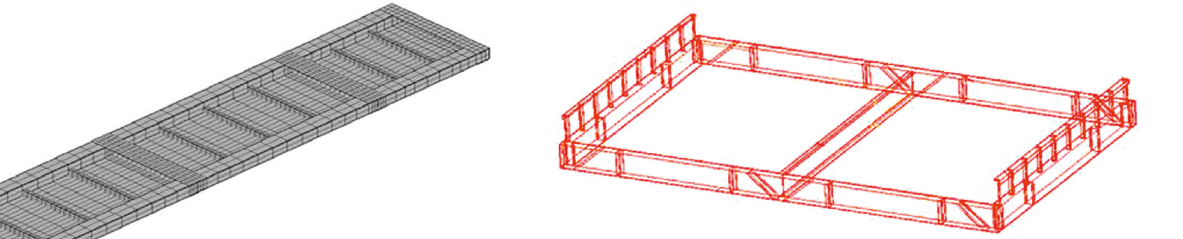
Figure 7: The model of the bottom beam.